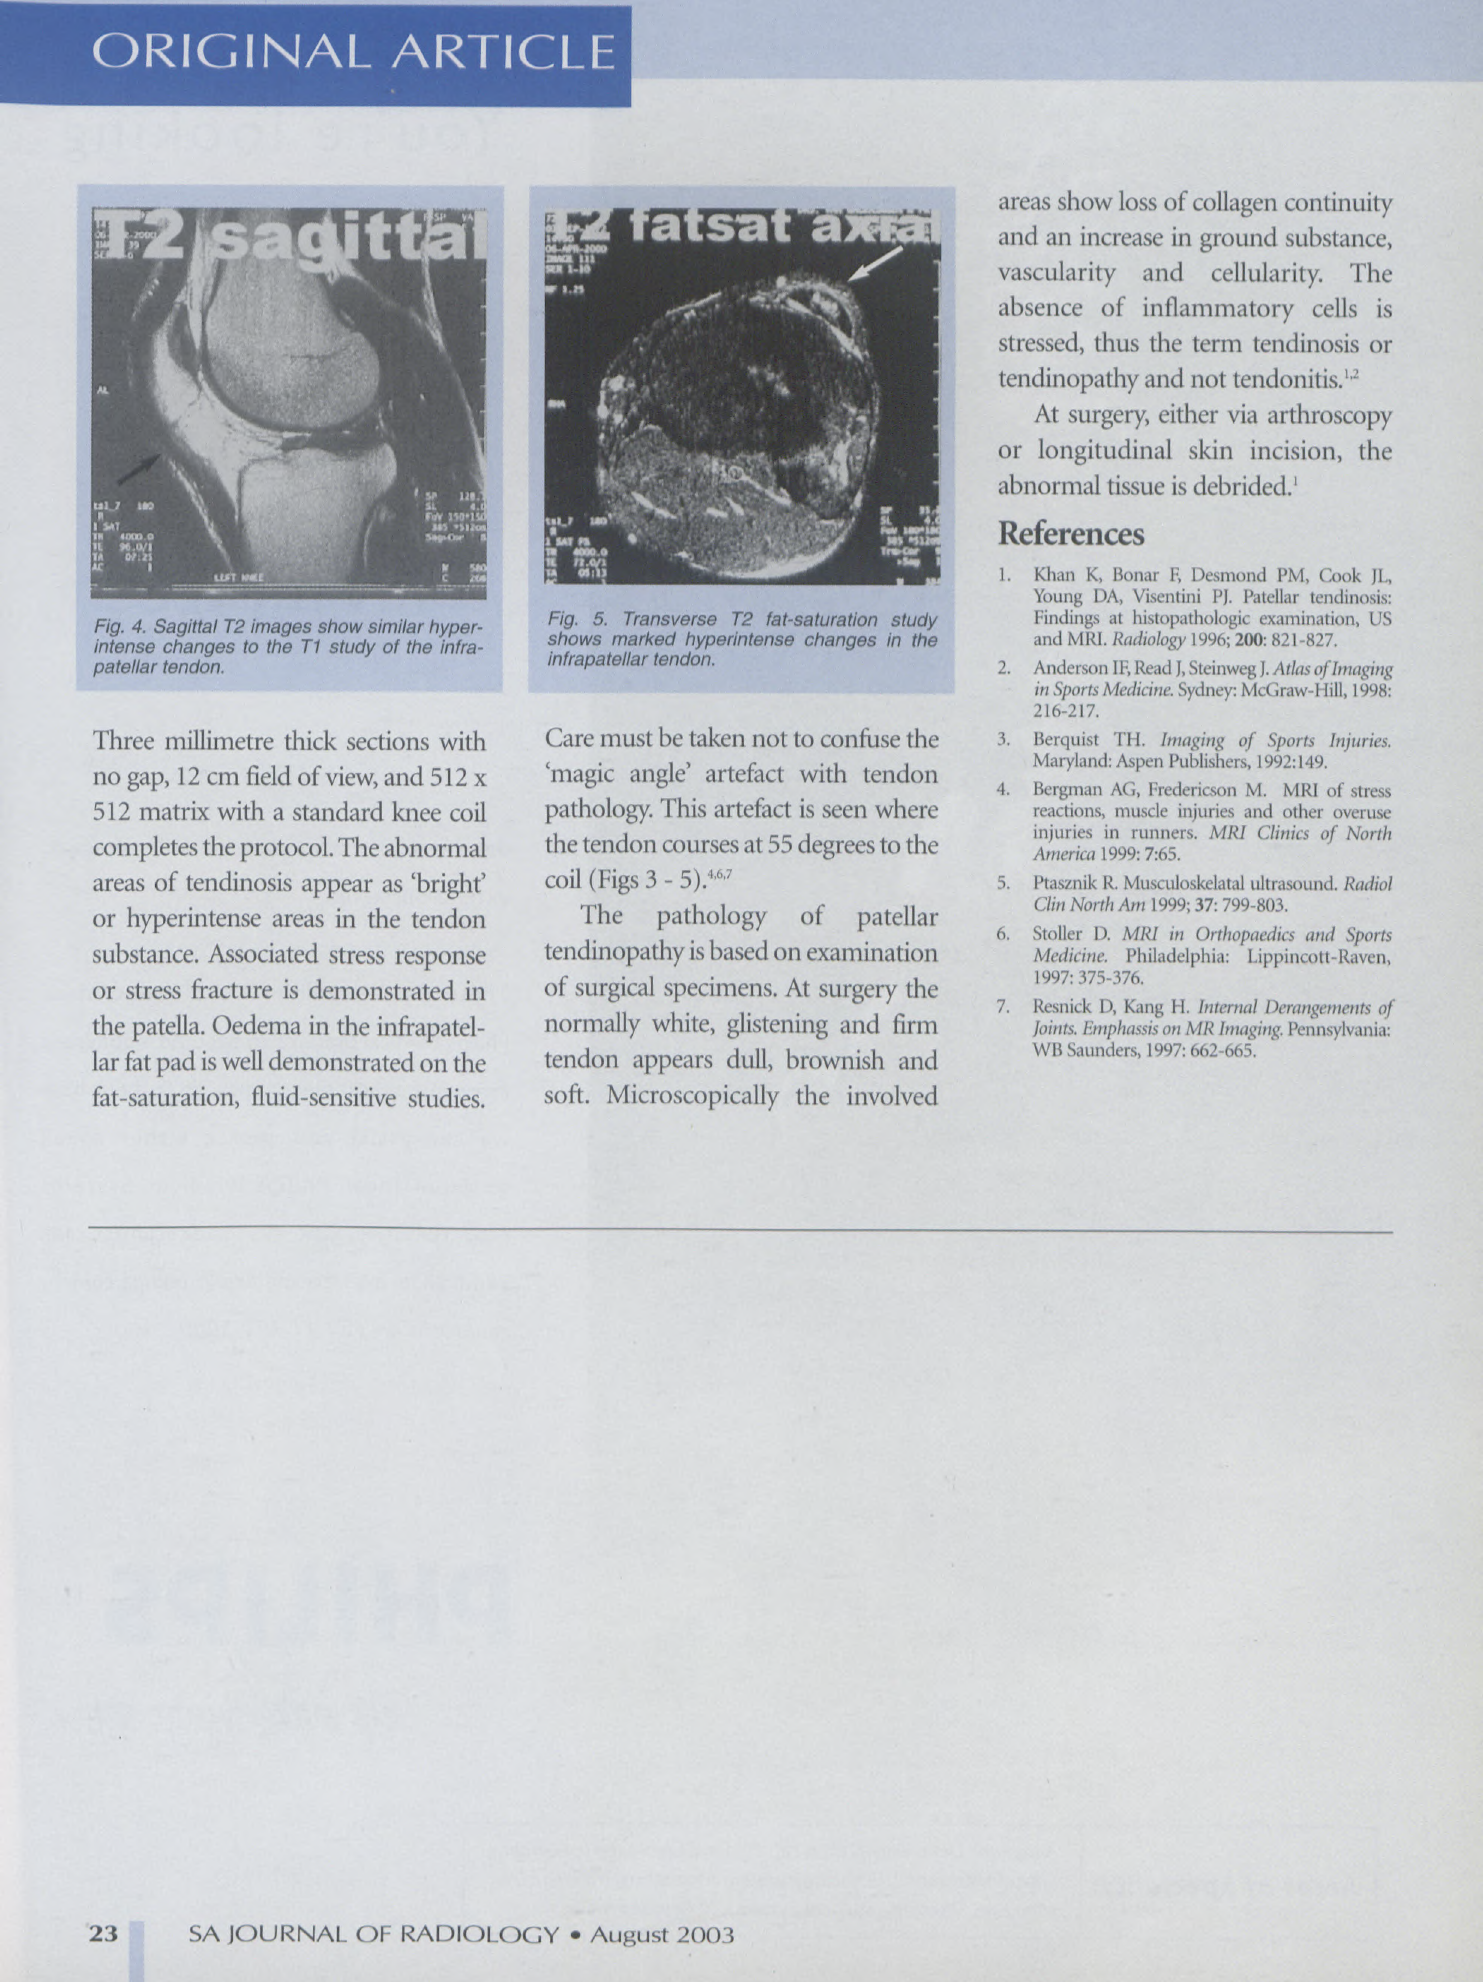
Fig. 5. Transverse T2 fat-saturation study shows marked hyperintense changes in the infrapatel/ar